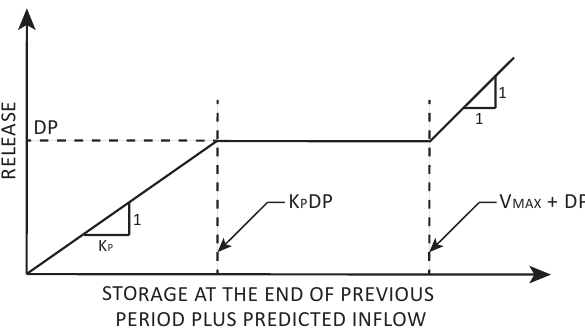
Figure 2. Standard operating policy, where D is per capita demand, P is population and V max is reservoir capacity (adapted from Shih and ReVelle, 1994).